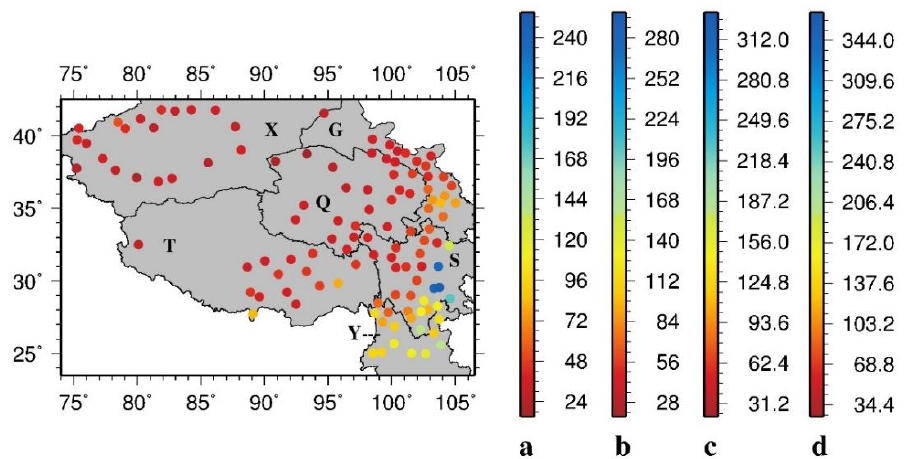
Figure 6. Thresholds of extreme daily precipitation for the 4 recurrence periods, 20-year ( a ), 50-year ( b ), 100-year ( c ), and 200-year ( d ) at the stations.